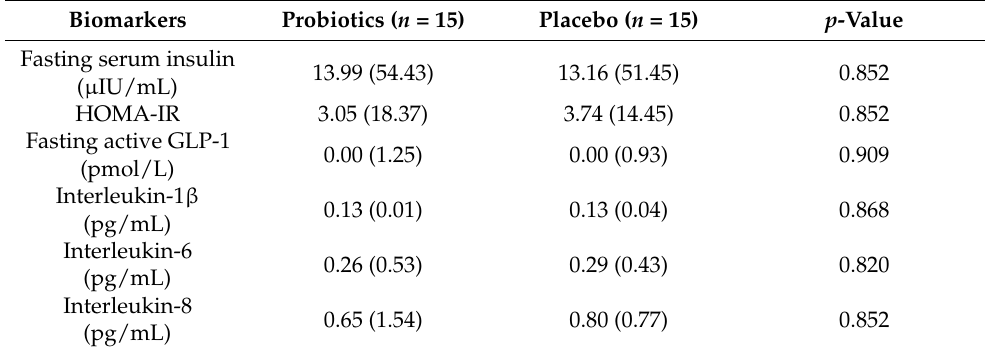
Table 2. Baseline glycemic and inflammatory biomarkers of the participants ( n =